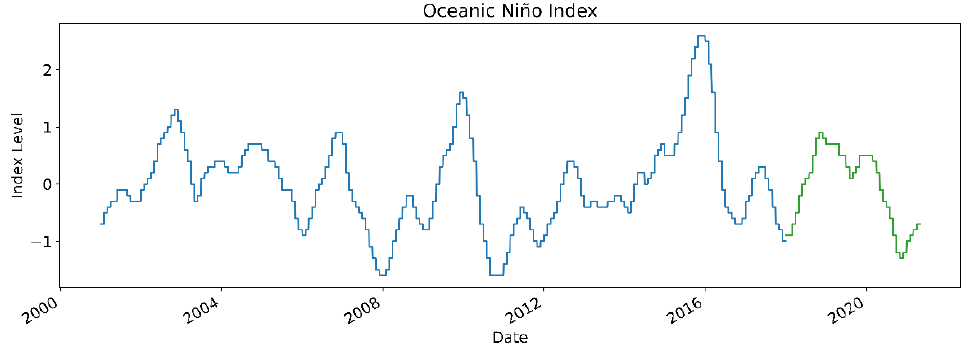
Figure 3. Historical daily rainfall for the Angat Dam in millimeters. Spikes in the observations are attributed to periods of intense rain caused by the monsoon season or typhoons. Since the Philippines has a distinct rainy season, the annual seasonality of rainfall is reflected in this plot. The yearly peaks usually occur in the middle of this rainy season. Blue observations denote the training set and green observations denote the test set.